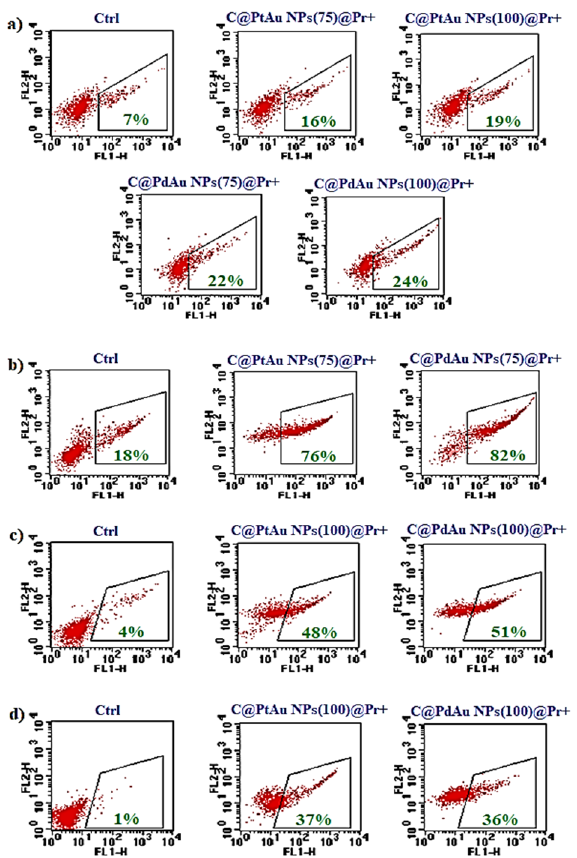
Figure 8. Apoptosis of ( a ) FHC, ( b ) SW480, ( c ) SW620, and ( d ) HCT116 cells determined by Annexin V-binding assay after the treatment with PtAu or PdAu NPs, followed by the proton beam irradiation. Dot-plots show flow cytometry analysis of cells—percent of apoptotic cells (green values) due to the binding of FITC-conjugated Annexin V (FL-1) in comparison to non-treated cells (Ctrl).